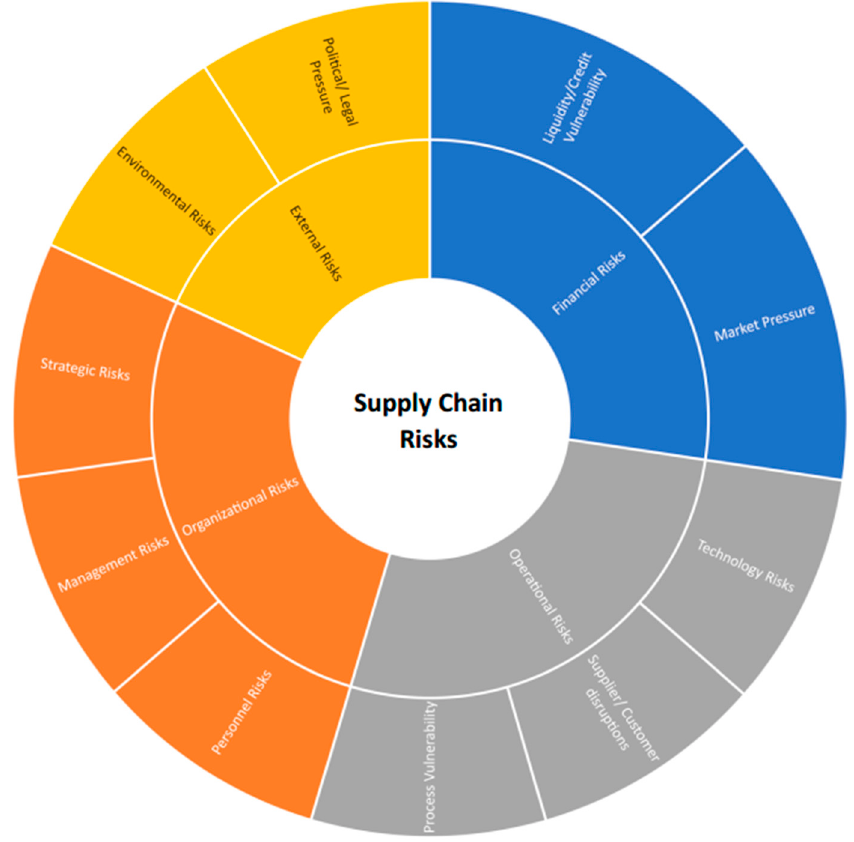
Figure 1. Supply chain risks.